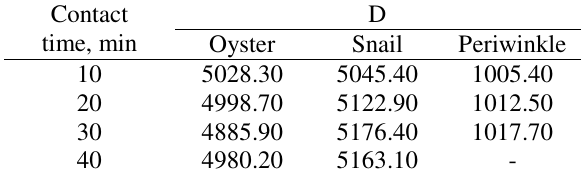
Table 5. Distribution coefficient for adsorption of Pb 2+ by oyster, snail and periwinkle